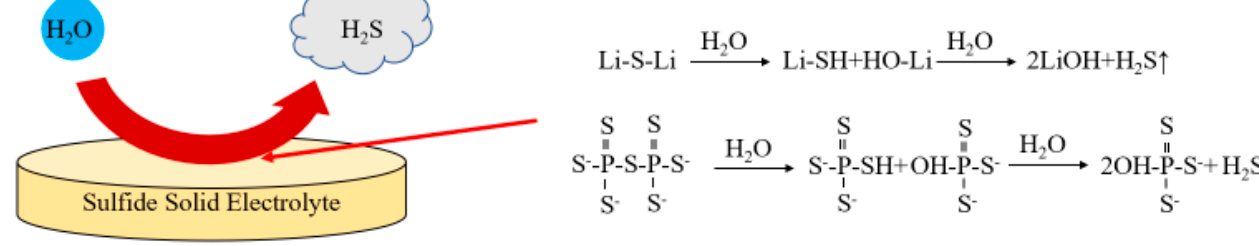
solid solution phases and proposed that the solid solution range was 0 < k ≤ 3.6 based ductivity of 1.5 × 10 − 3 S · cm − 1 as well as good stability in the air atmosphere. Liu et